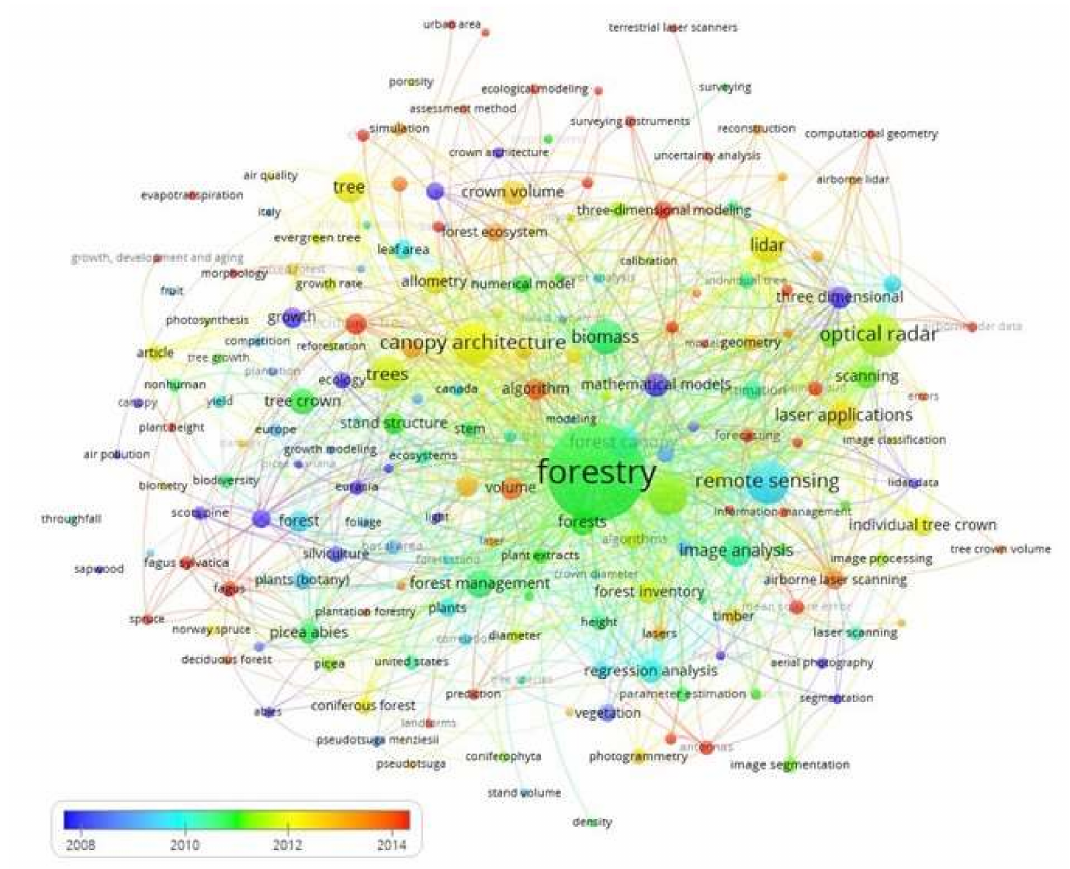
Figure 19. Research trend evolution to tree crown volume